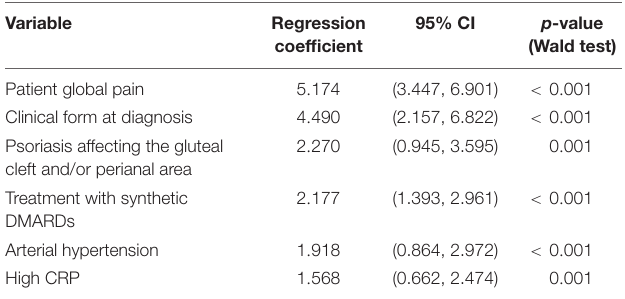
TABLE 3 | Variables associated with severe disease selected in the logistic regression